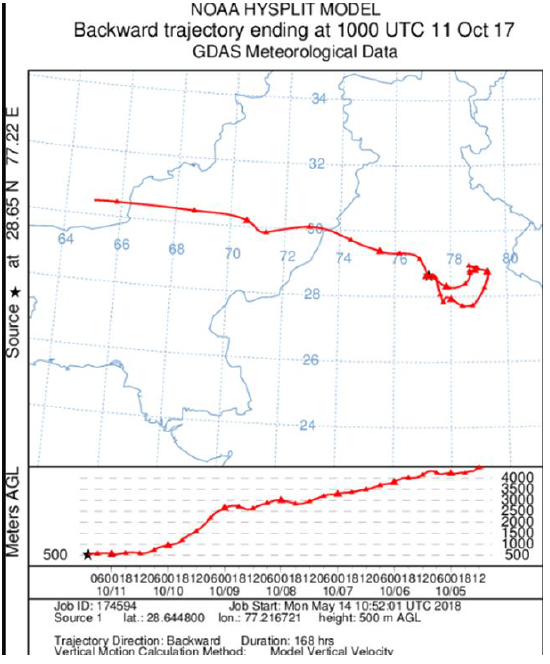
Figure 13: Backward Wind Trajectory, October